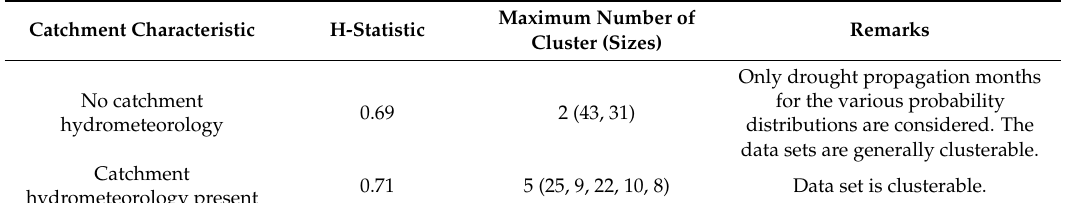
Table 5. Clustering tendency statistic.